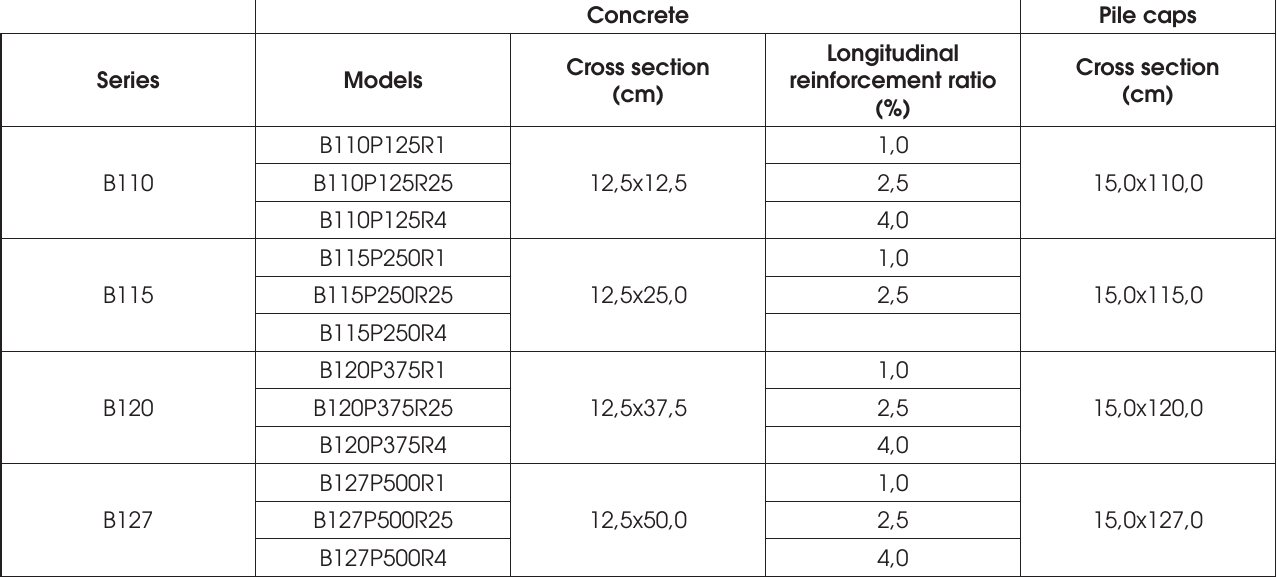
Measures of columns, pile caps and piles and longitudinal reinforcement